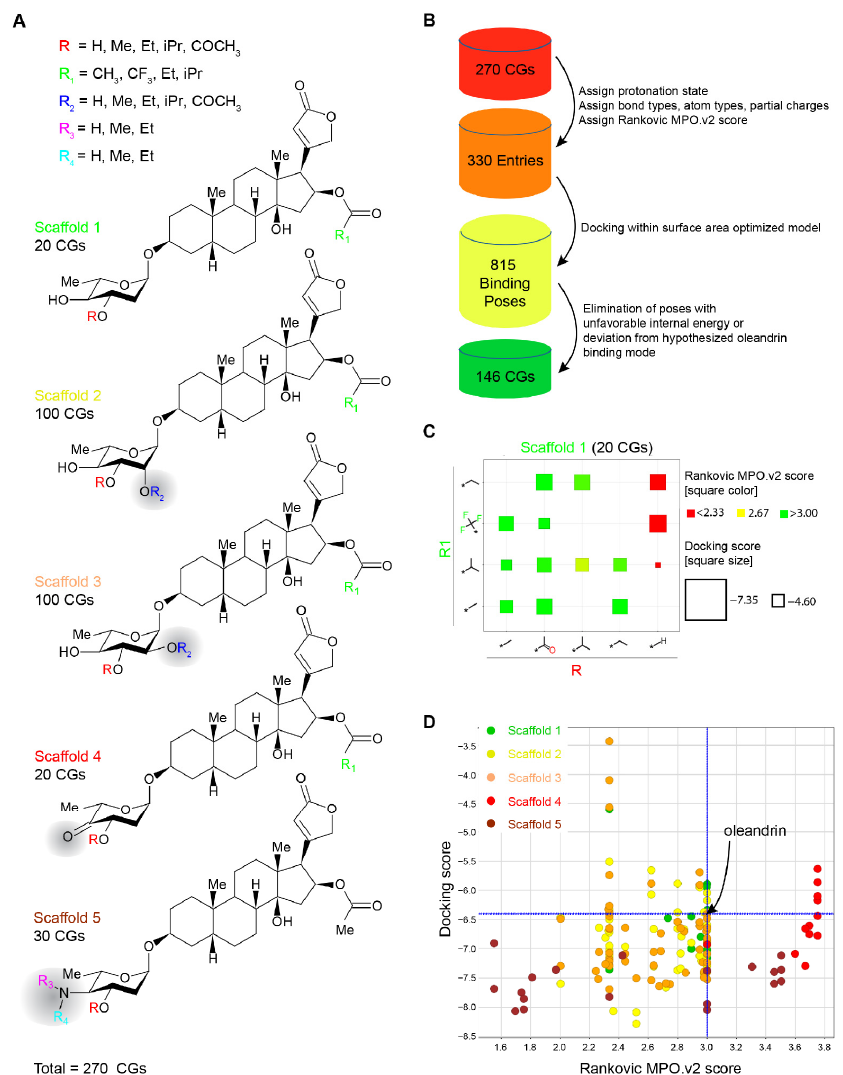
Figure 3. In silico filtering of CG derivatives accessible through chemical derivatization based on their predicted docking scores and Rankovic multi-parameter optimized (MPO, version 2) BBB penetrance scores. ( A ) Design of CG scaffolds and chemically accessible modifications evaluated, giving rise to a combinatorial total of 270 CGs considered. ( B ) Workflow for the in silico assessment of candidates. The assignment of protonation states and partial charges increased total CG ligands evaluated to 330, a number that further increased to 850 once alternative binding poses, predominantly caused by freely rotating bonds were considered. The elimination of binding poses with unfavorable internal energy or deviation from the hypothetical oleandrin binding pose led to a 146 CGs that passed these filters. ( C ) Exemplary chart depicting results from the evaluation of Scaffold 1 CG derivatives. The position of Scaffold 1 combinatorial candidate CGs within the chart can be deduced from the R1 and R chemical modifications defined on the two axes. The color scheme reflects Rankovic MPO.v2 scores [48] (a high score, represented by a green square, indicates high predicted BBB penetrance) and the size of squares reflects docking strength (a low docking score, represented by a large square, indicates strong binding). The absence of a square indicates that no binding pose that passed filter criteria (see above) was found. Asterisks indicate sites used for the attachment of the respective combinatorial moieties. ( D ) Summary chart depicting results from the evaluation of Rankovic MPO.v2 scores and docking scores for all five scaffolds. Note that CGs derived from Scaffold 4 had similar docking scores as derivatives from other scaffolds but excelled based on their high predicted BBB penetrance. As a reference, we show the position of oleandrin in this chart at the intersection of the two blue